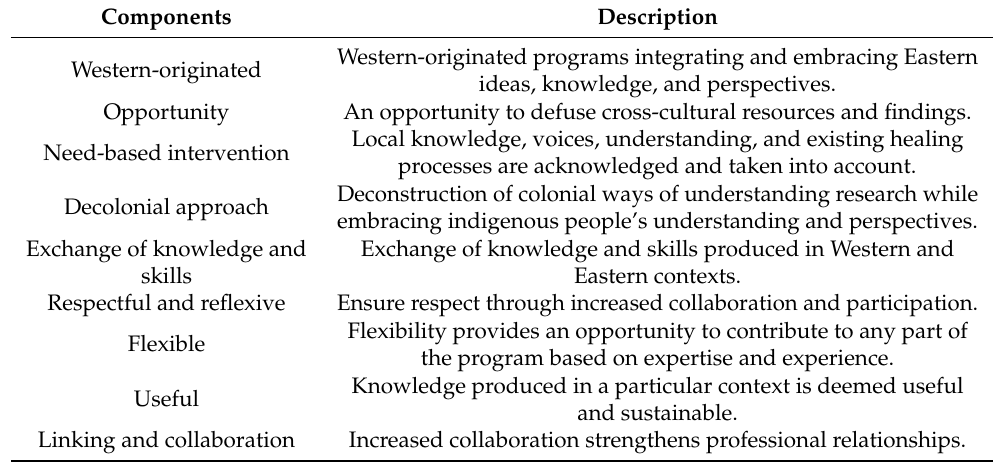
Table 1. The proposed model of supervision: WONDERFUL. Components Description